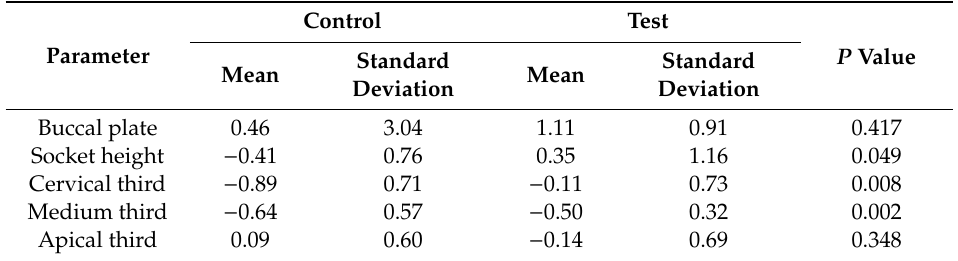
Table 3. Di ff erences between the means (in mm) of the gains / losses between the TG1 and TG2 for each